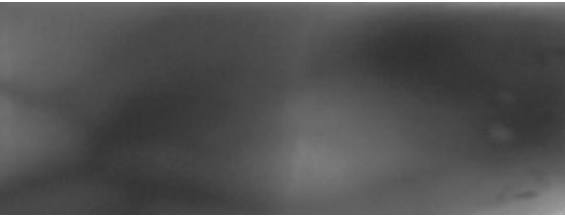
Figure 3. Image after ROI processing.